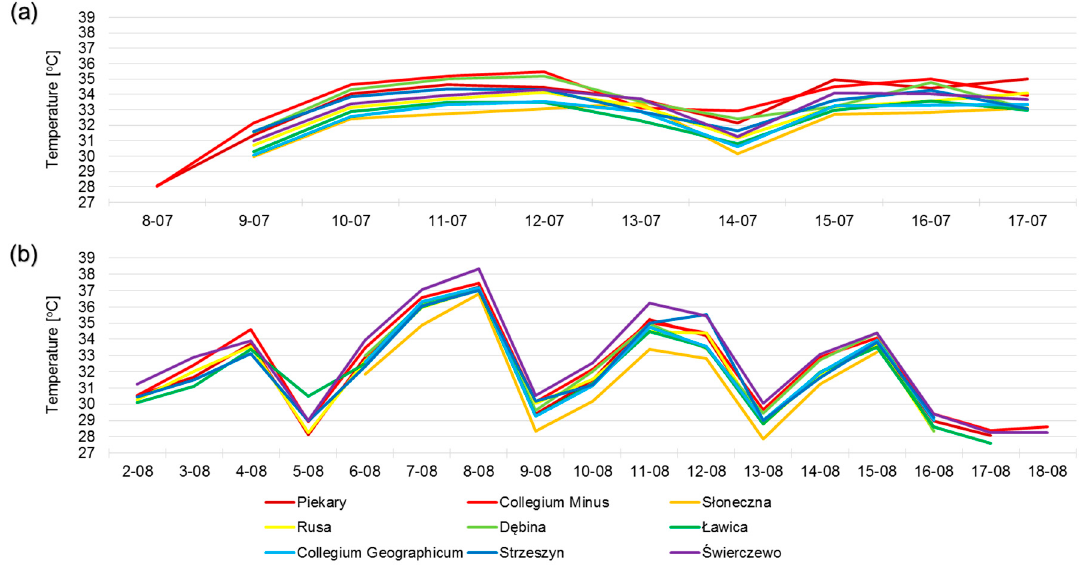
Figure 5. T max during the heat wave of 8–17 July 2010 ( a ) and 2–18 August 2015 ( b